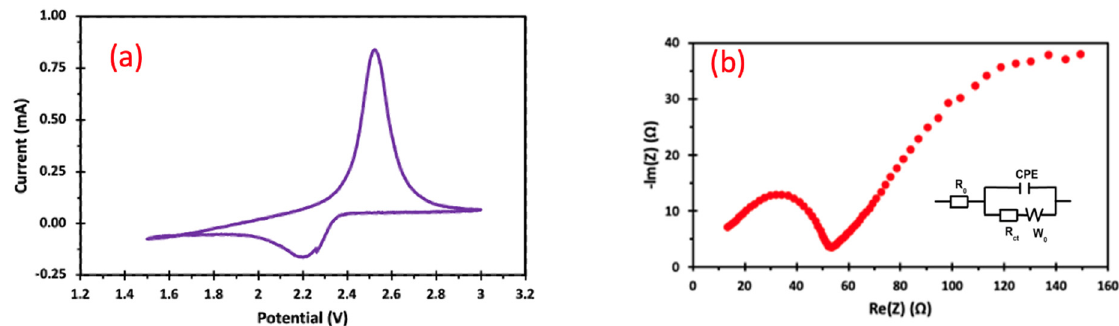
Figure 4. ( a ) Cyclic voltammogram curve of the S@RGO/GN composite electrode between 1.5 and 3 V at a scan rate of 0.1 mV s − 1 , ( b ) Electrochemical impedance spectroscopy plot of S@RGO/GN with an equivalent circuit.